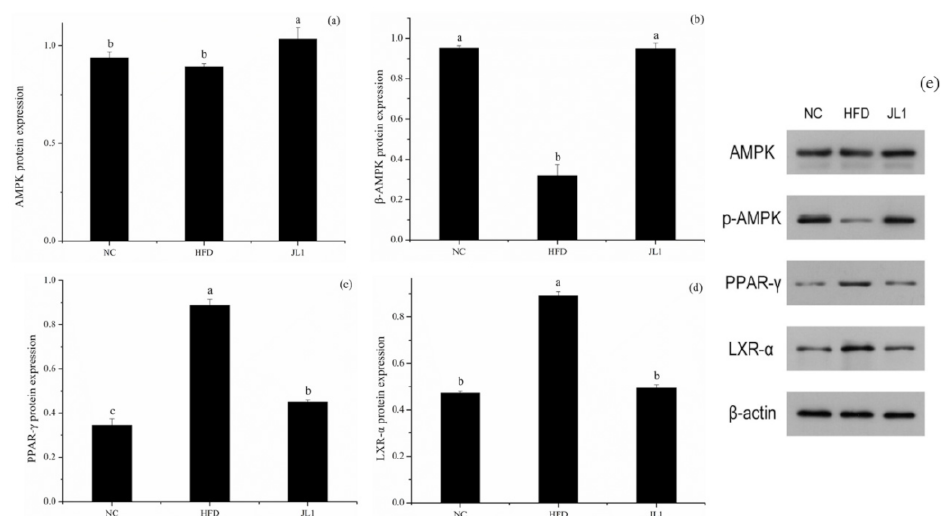
Figure 5. Effects of L. rhamnosus JL1on protein expression of mice liver. ( a ) AMPK protein expression, ( b ) p-AMPK protein expression, ( c ) PPAR- γ protein expression, ( d ) LXR- α protein expression, ( e ) Representative western blot for AMPK, p-AMPK, PPAR- γ and LXR- α . Each value represents the mean of 8 mice, and error bars indicate standard deviation ( ± SD). Different letters denote significant differences between different groups of mice ( p <